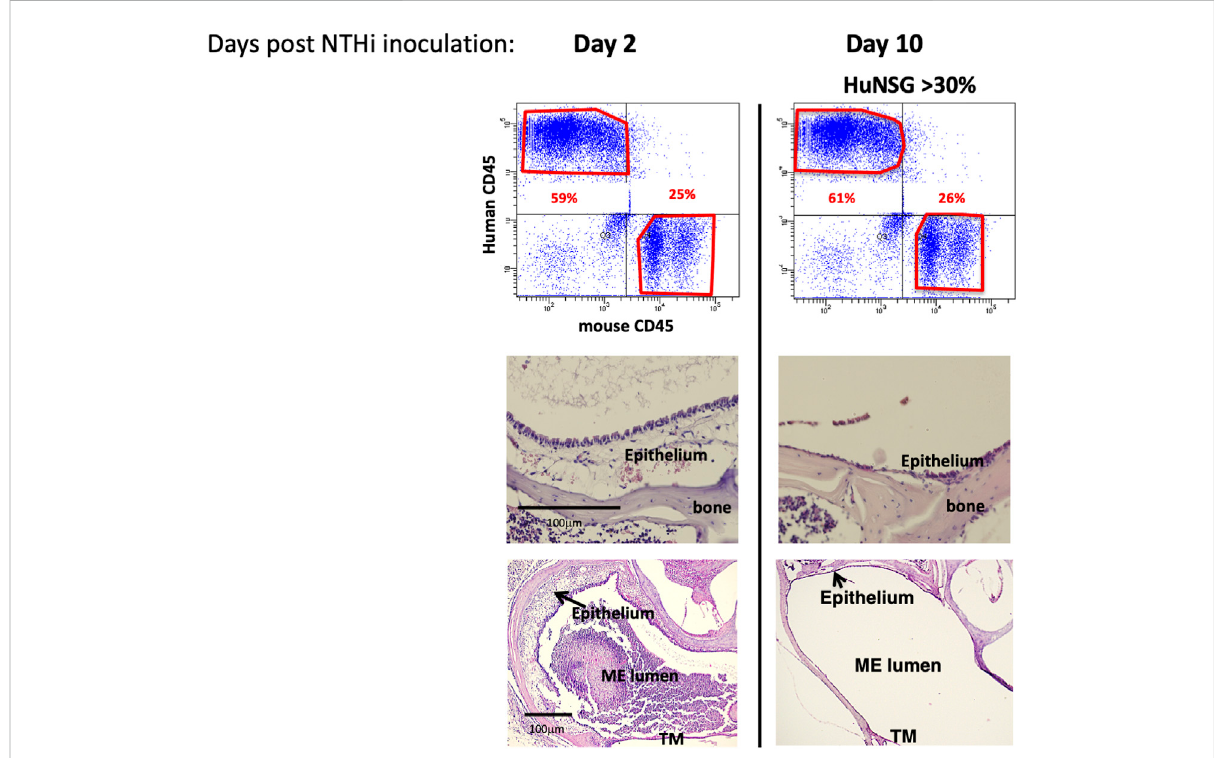
FIGURE 2 NTHi produced a functional ME immune/in fl ammatory response in humanized NSG mice. Examination of huNSG mice ME response to NTHi challenge at 2 and 10 days post infection ( n = 4 mice). Top: comparison of mCD45 + vs. hCD45 + cells in the blood by fl ow cytometry analysis con fi rming > 30% engraftment. Bottom: Histopathological changes in ME showing signi fi cant mucosal thickening and ME space leukocytic in fi ltration at 2 days after ME infection, and recovery prior to day